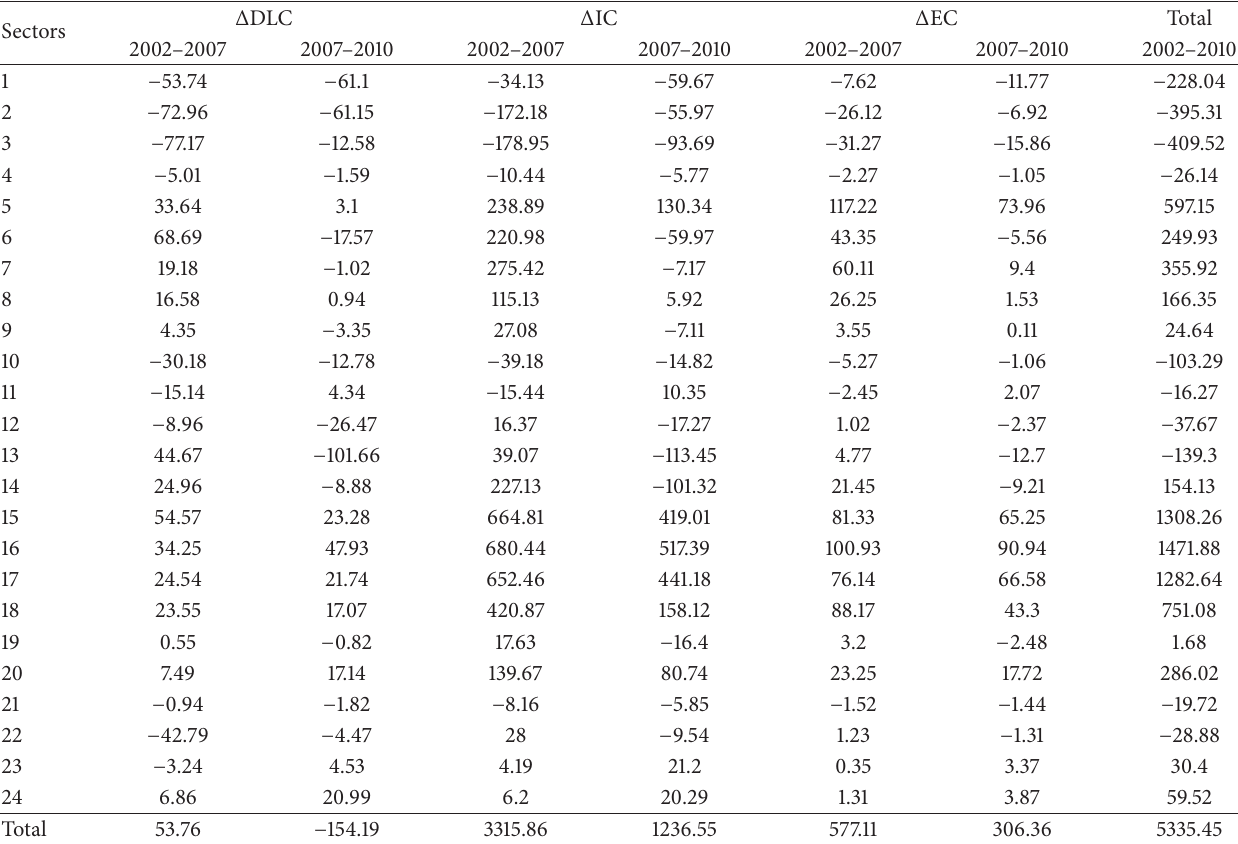
Table 2: The changes of carbon emissions in the three components in different